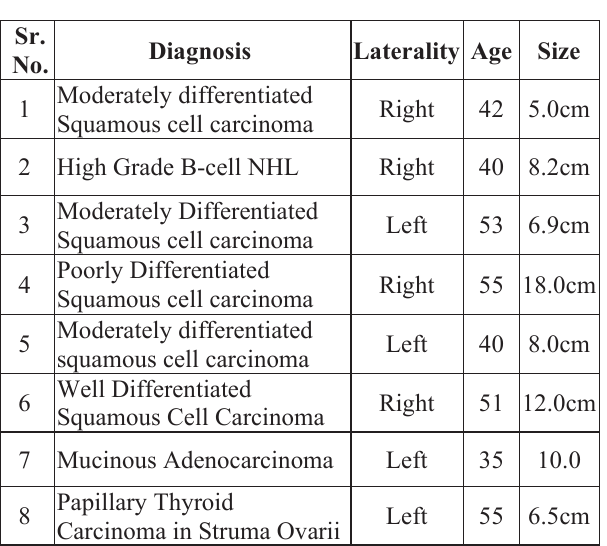
Table-4: Malignancies Arising in